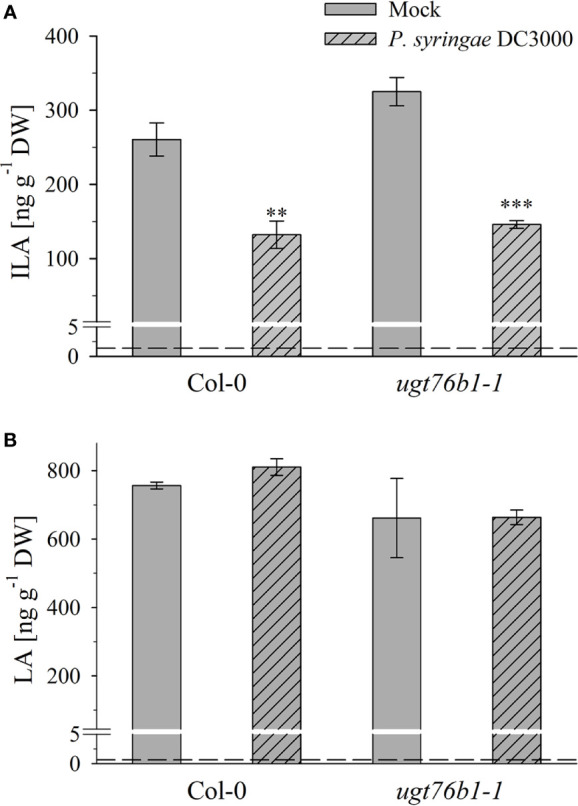
Isoleucic acid and LA abundance in response to Pseudomonas syringae virulent strain infection. Levels of (A) ILA and (B) LA aglyca 24 h post P. syringae DC3000 infection in leaves of Arabidopsis Col-0 and ugt76b1-1 plants compared to mock controls. Means ± SE (n = 4) are plotted. Asterisks indicate statistically signiﬁcant treatment effect compared to mock control (t-test), ∗∗p < 0.01, ∗∗∗p < 0.001. Dashed lines indicate the limit of detection (see section “Materials and Methods”).